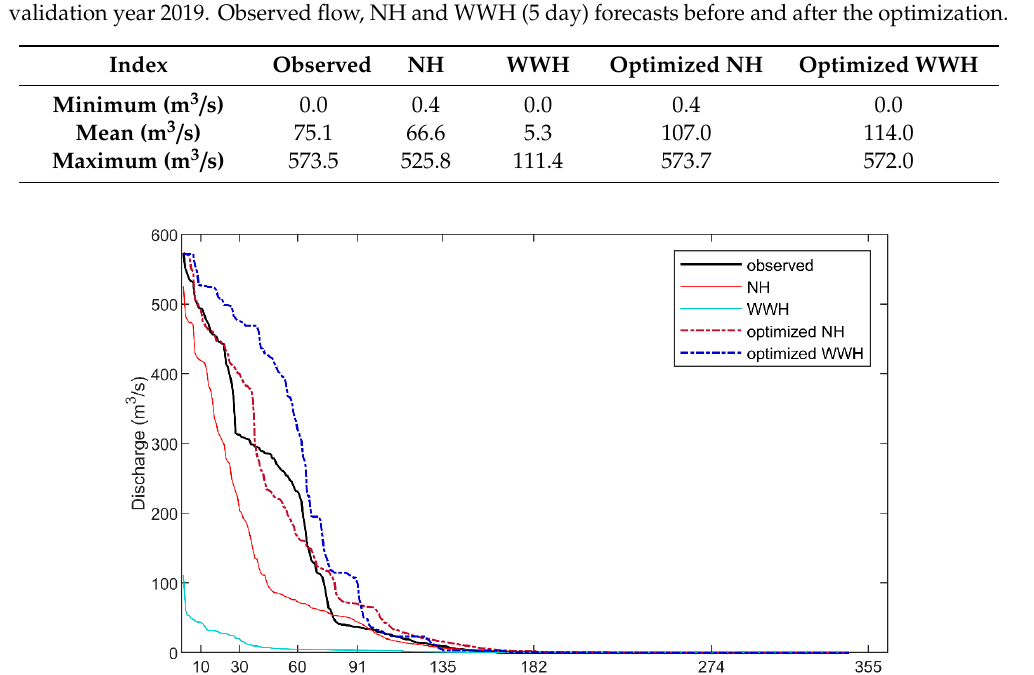
Figure A2. Hydrograph of original and optimized 5-day forecasts from NH and WWH in Bossey Bangou for the wet season of the validation year (1 June 19–31 Octomber 19). Continuous and categorical indices and operational availability in Garbey Kourou (Table A2) and Bossey Bangou (Table A3) hydrometers. Table A2. Continuous and categorical indices and operational availability for original and optimized forecasts at Garbey Kourou. Best performance is shown in bold. Model